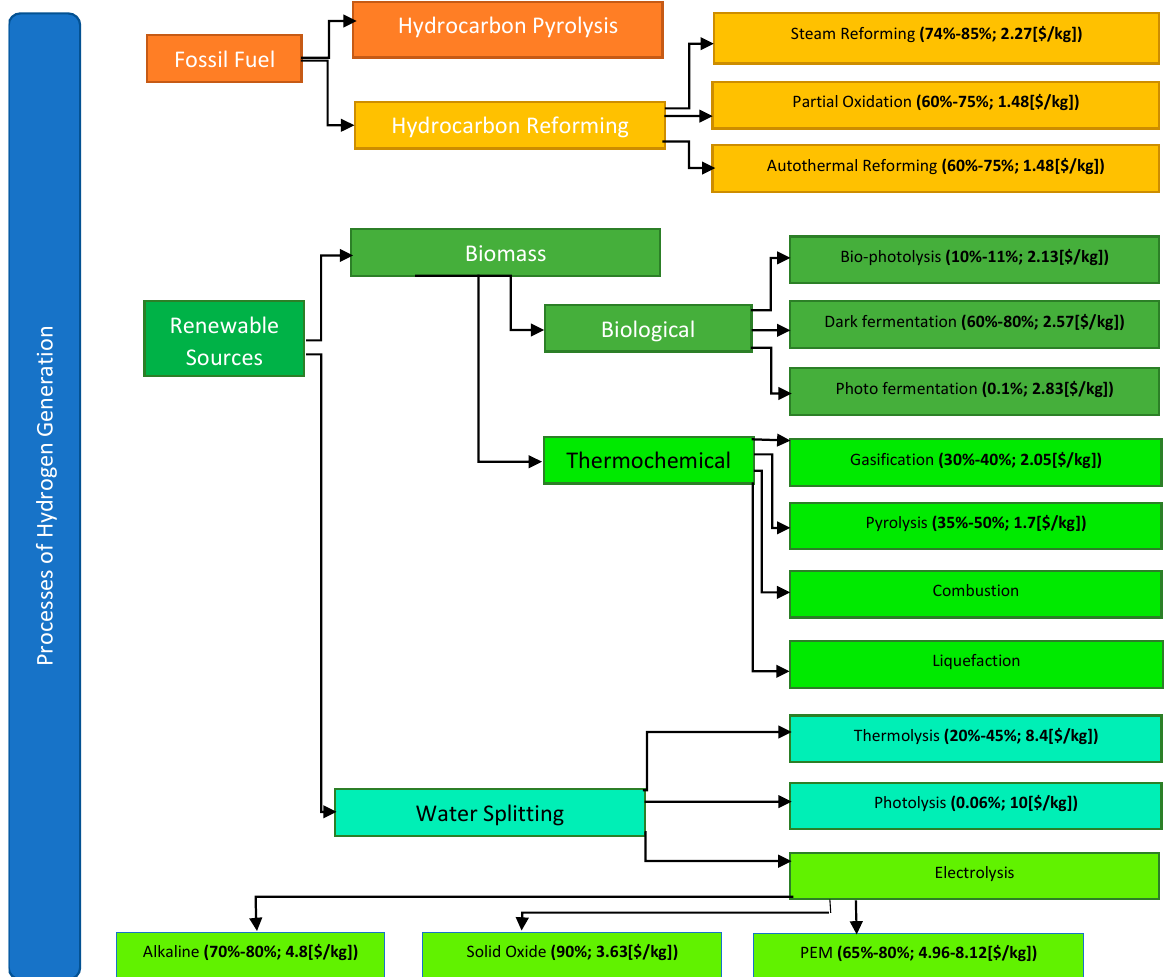
Figure 1. Processes of Hydrogen generation efficiency and costs [2,3].